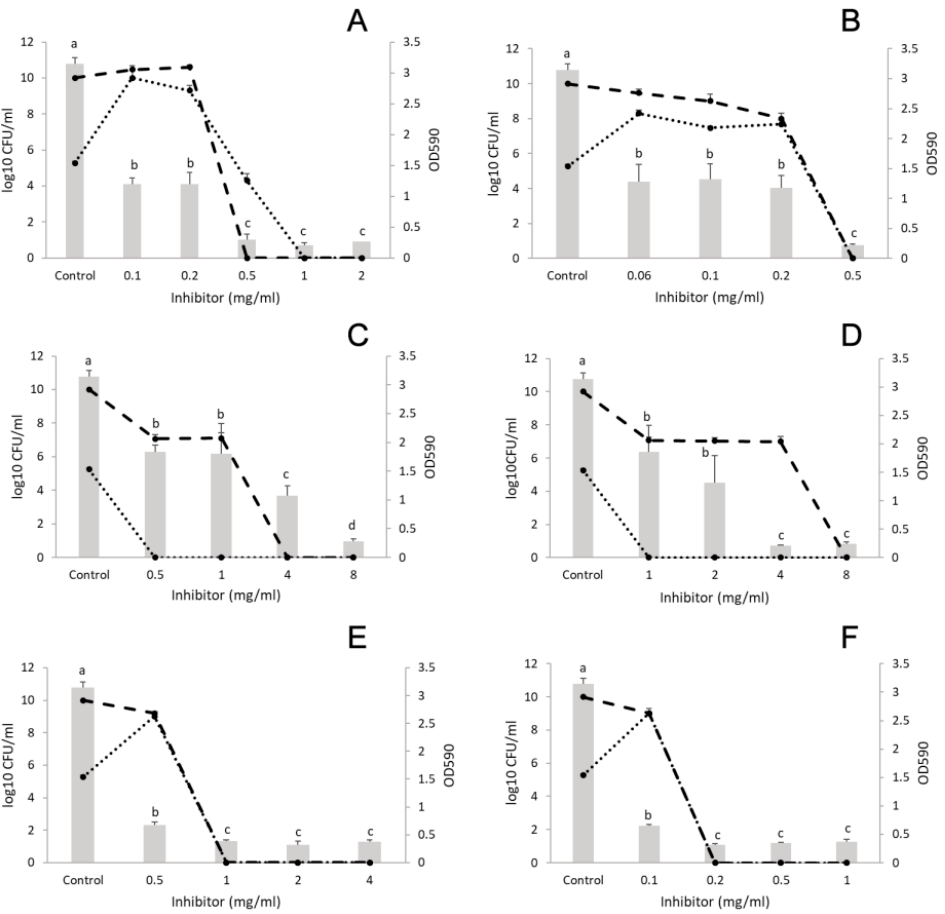
Figure 1. Effect of essential oils (EOs) on the biofilm formation of Listeria monocytogenes and Escherichia coli polymicrobial cultures. ( A ) cinnamon EO, ( B ) cinnamaldehyde, ( C ) marjoram EO, ( D ) terpinen-4-ol, ( E ) thyme EO, and ( F ) thymol. Columns represent the OD 590 values, dashed lines represent cell numbers of L. monocytogenes , and dotted lines cell numbers of E. coli . Results are presented as mean ± standard deviation of six replicates. Different letters indicate statistically significant differences between columns ( p < 0.05).